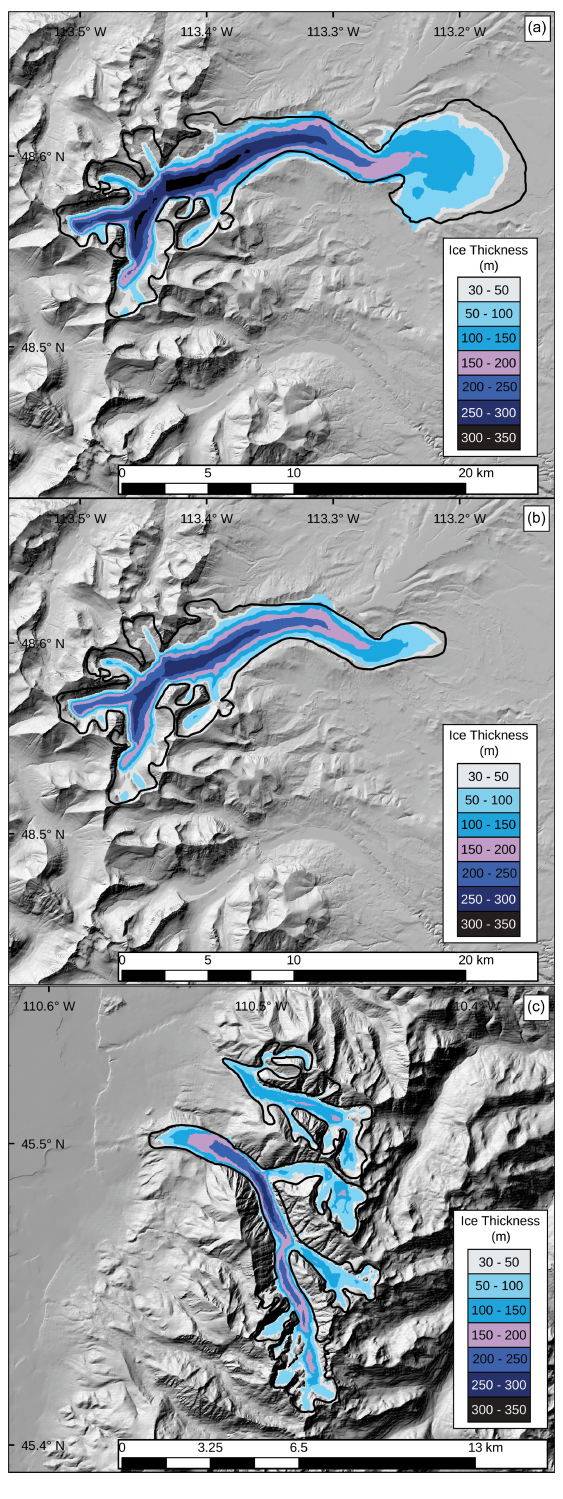
Figure 6. Ice thickness maps generated from coupled energy–mass balance and ice-flow modeling for (a) Cut Bank terminal, (b) Cut Bank recessional, and (c) Pine Creek and South Fork Deep Creek in the Absaroka Range. Modeled ice extents were matched to field evidence (black outlines) by varying precipitation ( P x ) and temperature ( T d ) by multiplicative and additive changes, respectively. For each simulation, we found a series of P x – T d combinations that produced modeled ice extents that satisfactorily matched field evidence. Ice extents shown here use 100% modern precipitation and temperature depressions of − 9.2, − 8.0, and − 8.5 for the Cut Bank terminal (a) , Cut Bank recessional (b) , and Absaroka Range model domains,